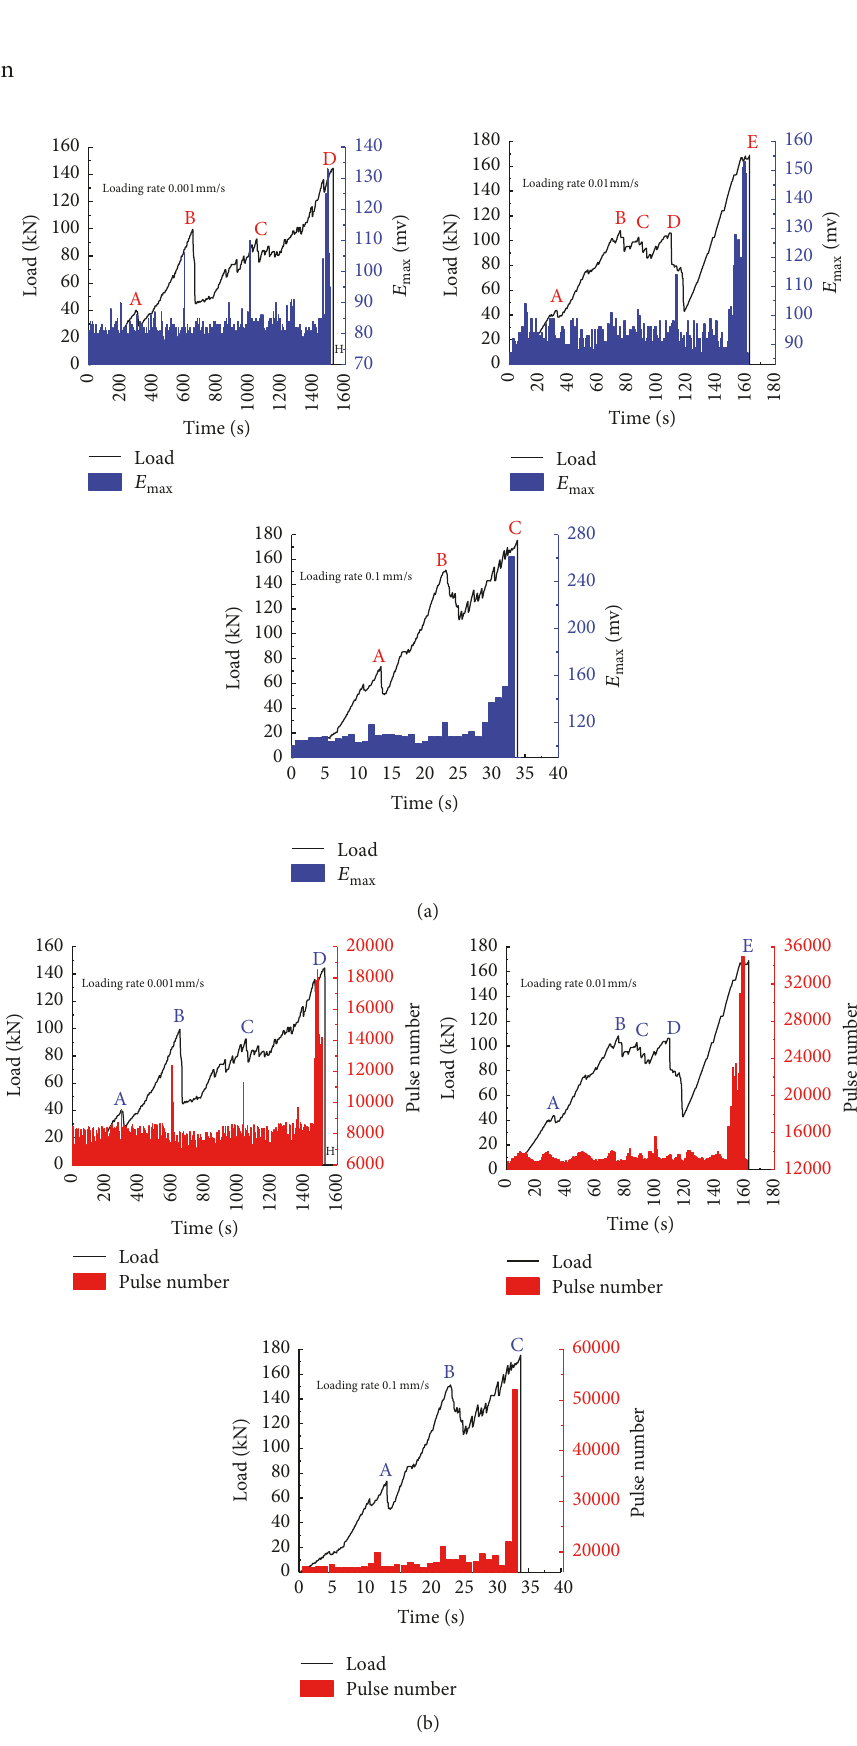
Figure 3: Curves of EME parameters under different loading